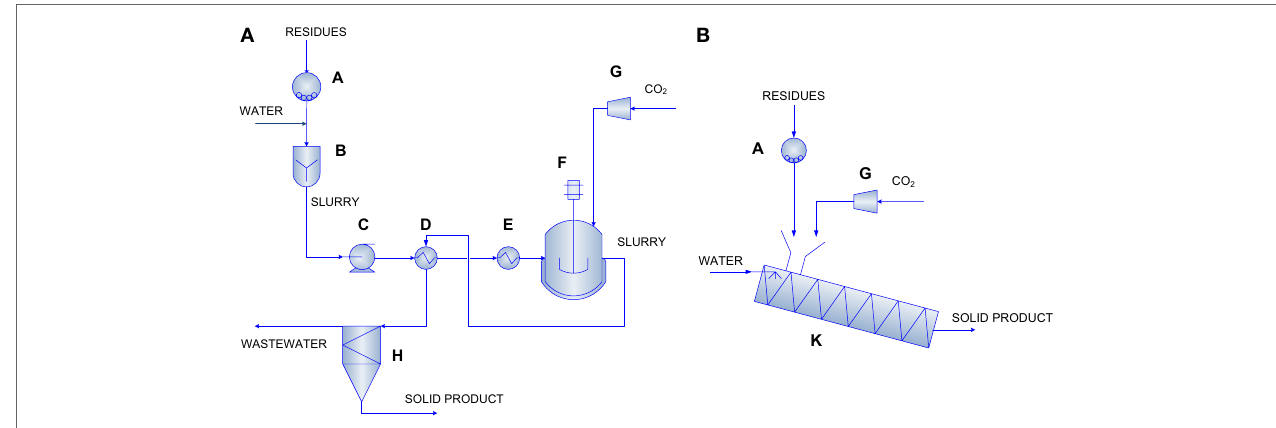
FigUre 1 | carbonation process layout for the slurry-phase (a) and the thin-film (B) routes [reprinted with permission from Zingaretti et al. (2014) ] . Copyright (2014) American Chemical Society. A = mill; B = rapid mixing unit; C = pump; D, E = heat exchangers; F, K = carbonation reactors; G = compressor; H = settling